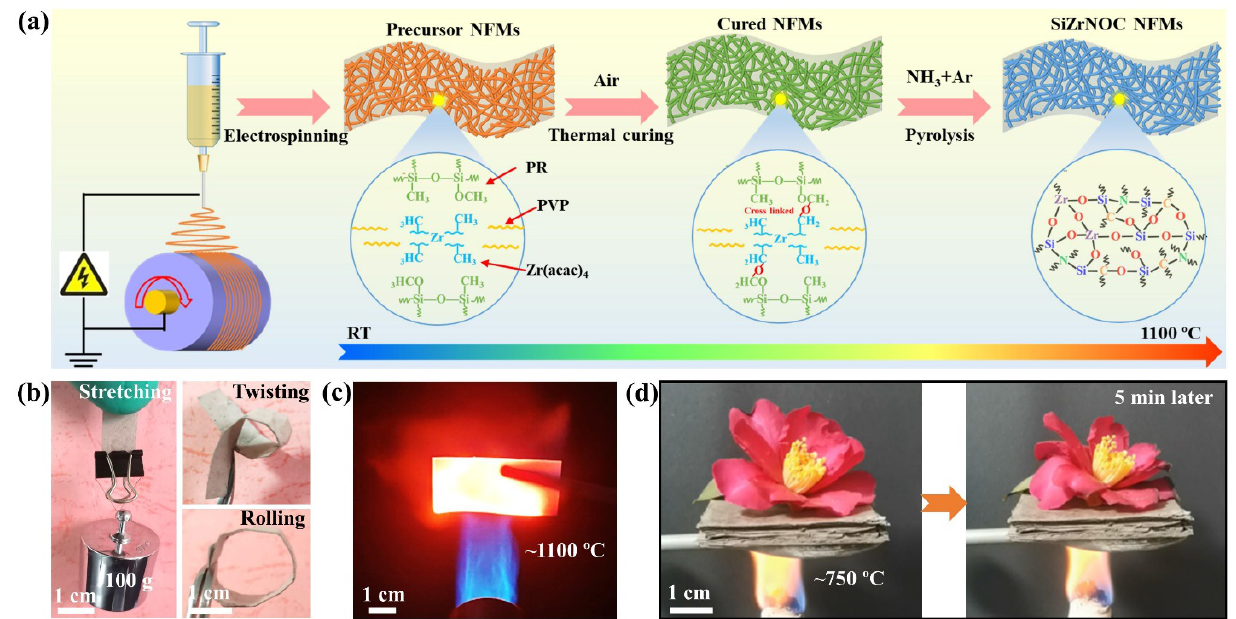
Fig. 1 (a) Schematic illustrating the preparation process of SiZrNOC NFMs, (b) SiZrNOC NFMs that could hang a 100 g steel weight and were twisted and bended without fracture, (c) excellent fire resistance of SiZrNOC NFMs to withstand butane blowtorch flame (~1100 ℃ ), and (d) photograph demonstrating that a piece of SiZrNOC NFM with a thickness of 0.5 cm can protect fresh flower from withering for at least 5 min under heating of alcohol lamp flame (~750 ℃ ).